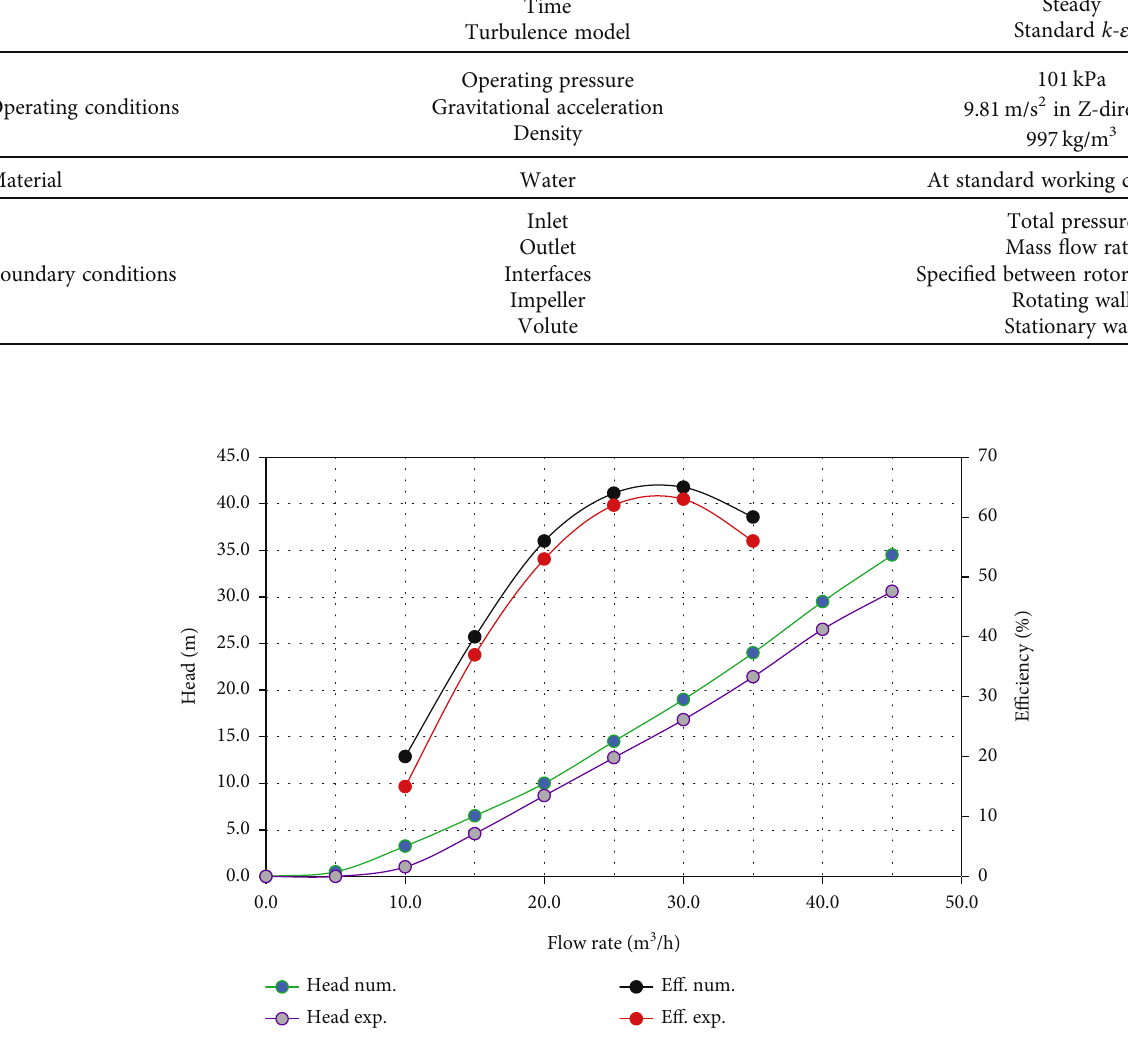
Figure 3: Comparison of numerical and experimental